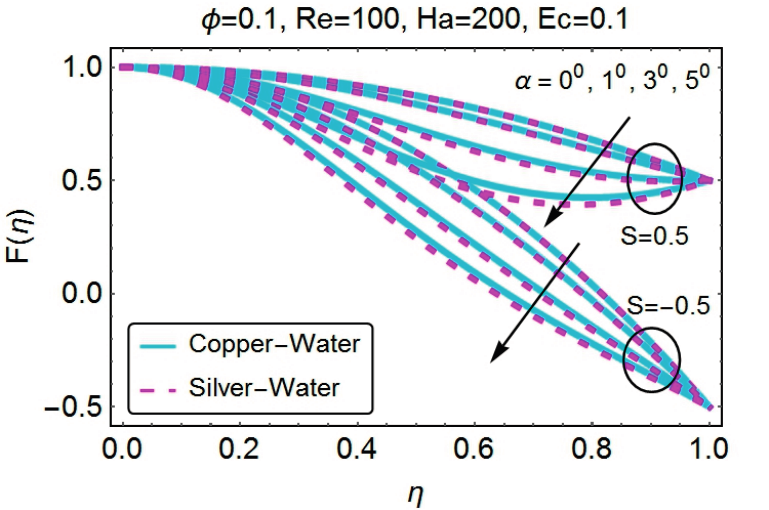
Figure 2. Change in velocity for varying α (divergent channel).